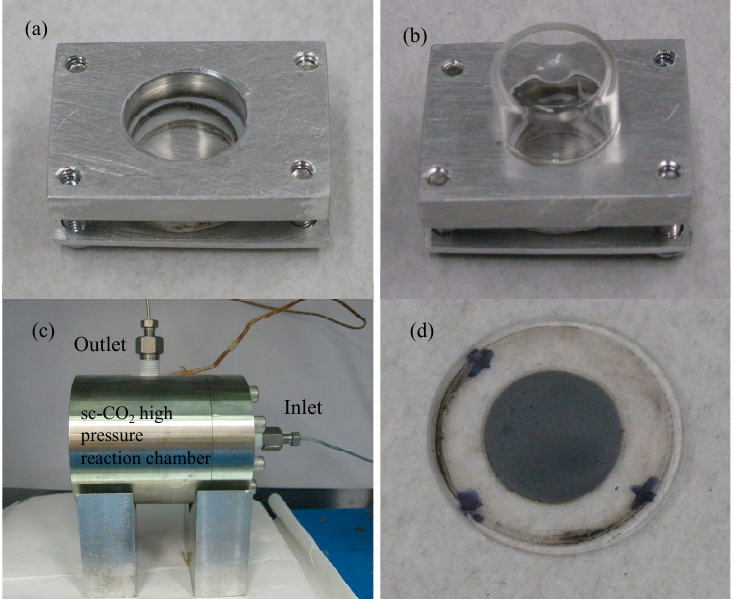
Figure 1. Apparatus used to form the samples. ( a ) Substrate holder with a diameter of approximately 1 cm. ( b ) Sample holder with a mini beaker on top. ( c ) sc-CO 2 high-pressure reaction chamber, and ( d ) the final product.